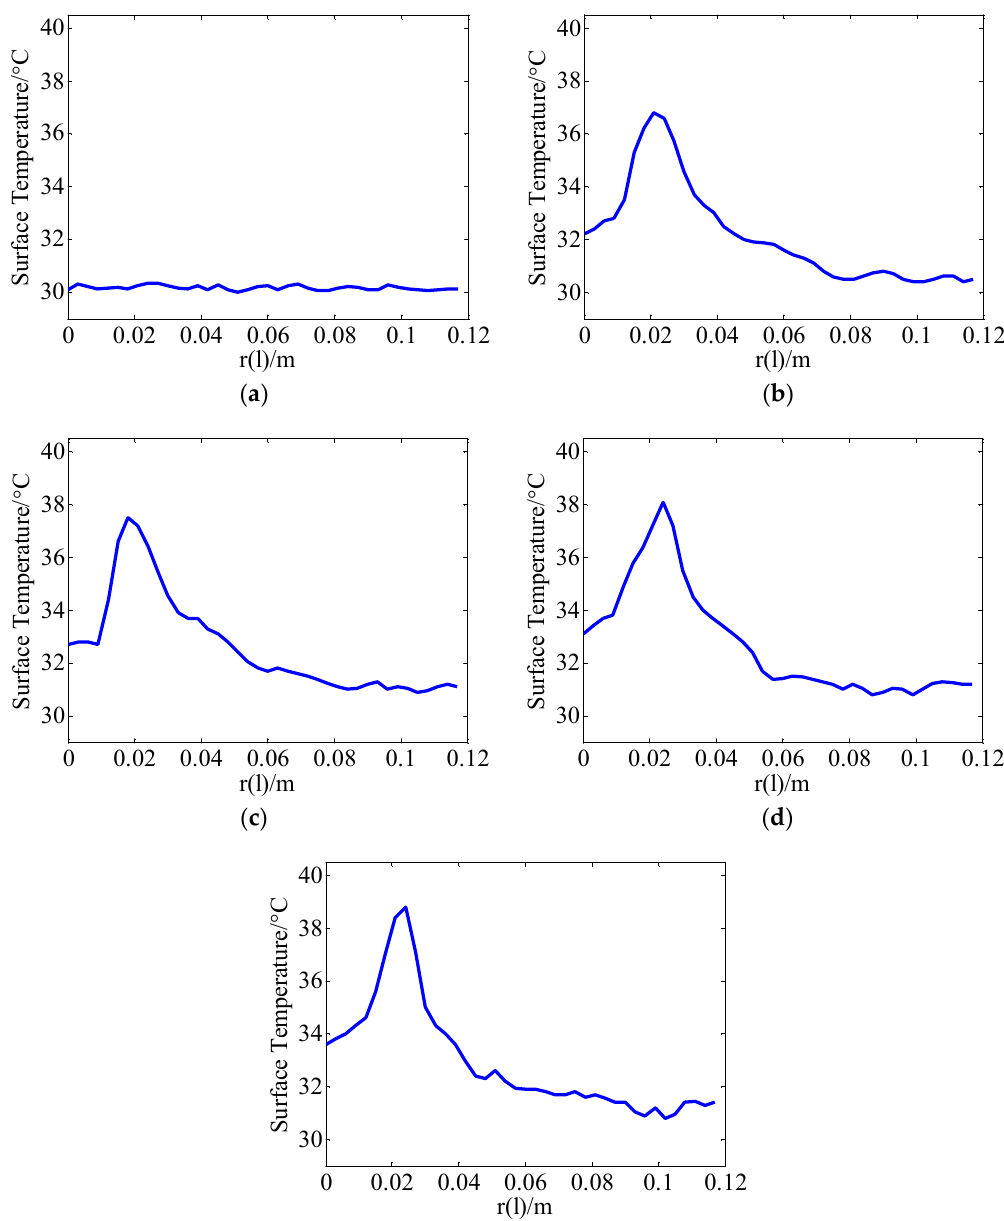
Figure 1. Temperature curves on the surface of wet contaminated insulators measured by an infrared imager. ( a ) Clean insulator; ( b ) Insulator of contamination grade Ⅰ ; ( c ) Insulator of contamination grade Ⅱ ; ( d ) Insulator of contamination grade Ⅲ ; and ( e ) Insulator of contamination grade Ⅳ.